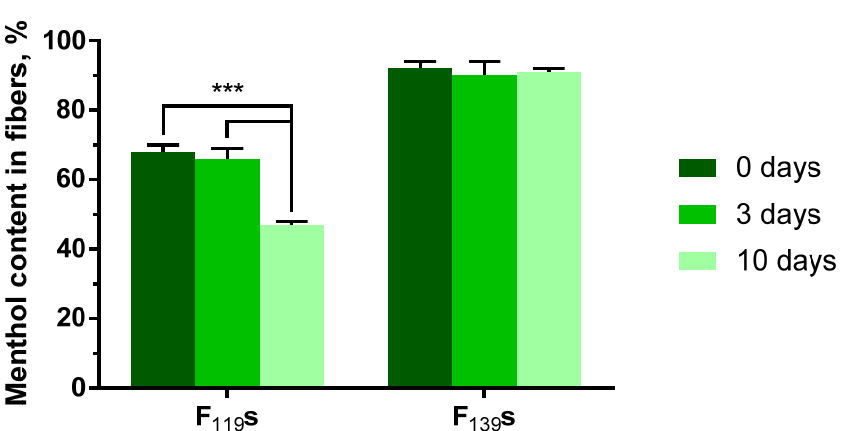
Figure 3. Stability over time of the menthol content in loaded F 119 s and F 139 s. The amount of menthol in acetone-dissolved fibers was analyzed by gas chromatography and mass spectrometry (GC-MS) at 0-, 3- and 10-days post fiber preparation. The data are represented in percentages relative to the amount of menthol initially added. Results are shown as the mean with standard deviation from three independent experiments performed in triplicate. Statistical analysis comprised two-way ANOVA corrected with Tukey’s test. ***, p < 0.001.